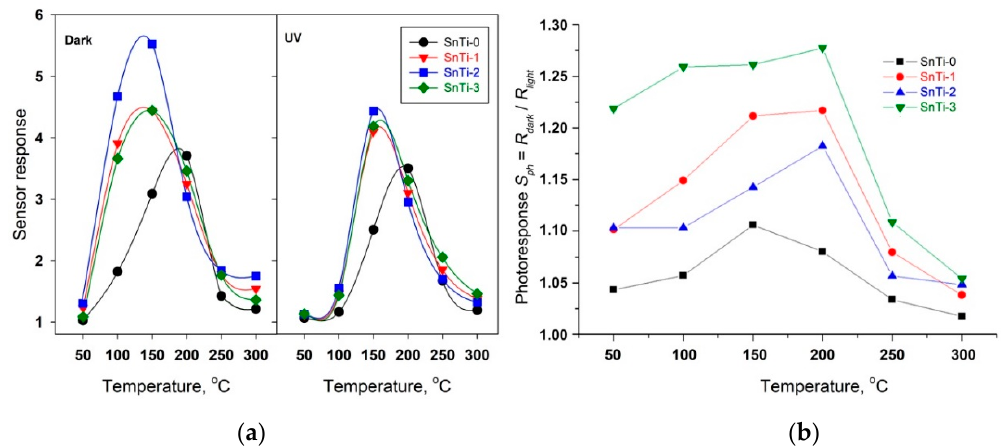
Figure 7. (a) Temperature dependencies of sensor response of the TiO 2 @SnO 2 nanocomposites toward 0.6 ppm HCHO in air in dark conditions (left) and under UV periodic illumination (right); (b) Temperature dependencies of effective photoresponse S Ph of the TiO 2 @SnO 2 nanocomposites in background air.